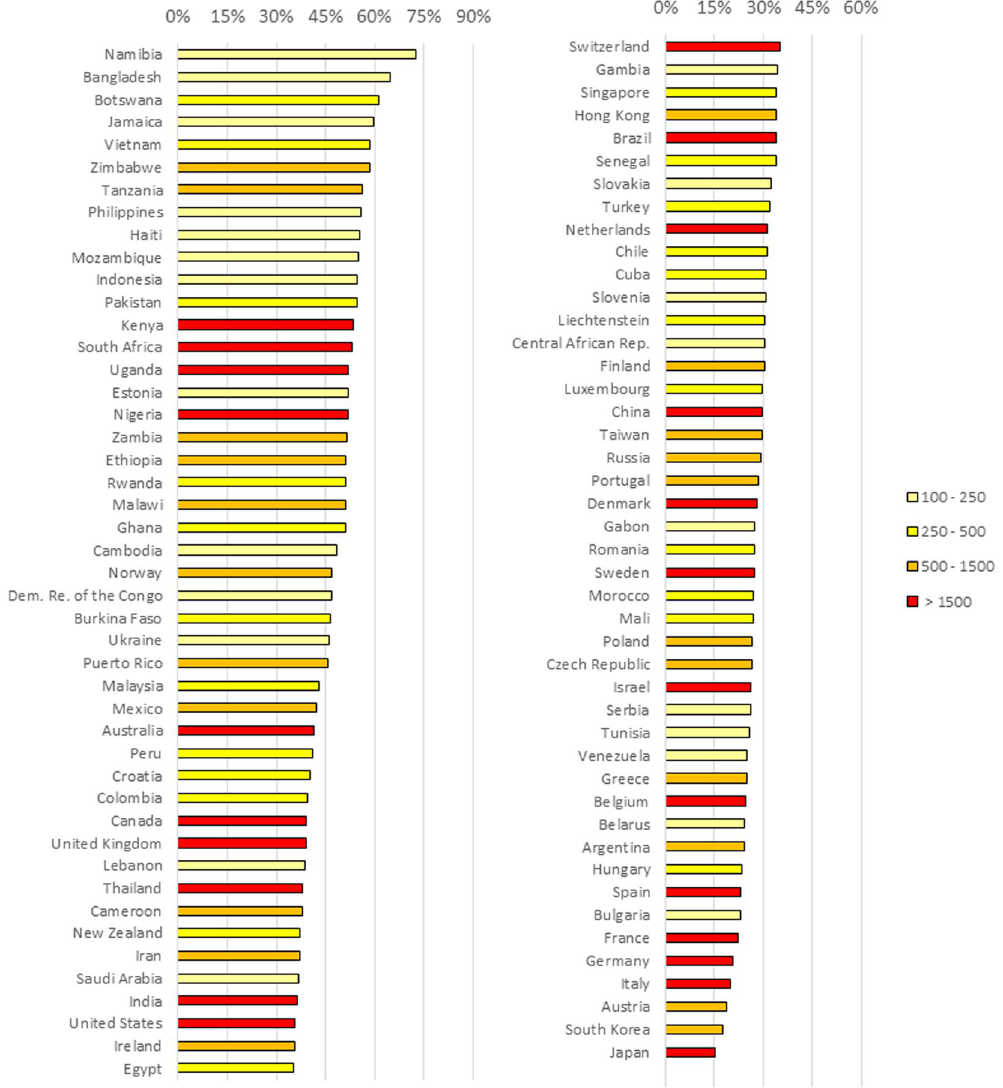
Figure 3. Share of BSS research in all HIV/AIDS papers of different countries. Note: For example, share of BSS research for Ethiopia is shown at 51% meaning that 51% of HIV/AIDS research content published by Ethiopian authors is on BSS topics. Only countries are shown that have published more than 100 papers during the period 1985 to 2012. Color coded by total number of HIV/AIDS